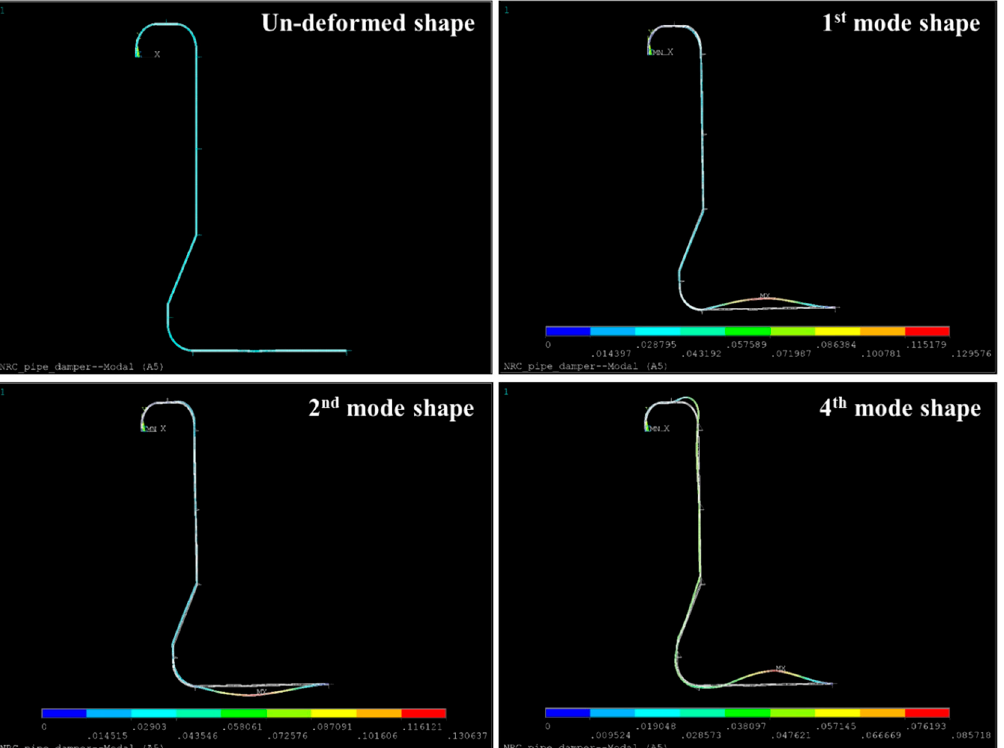
/ CR-1677 Benchmark piping system